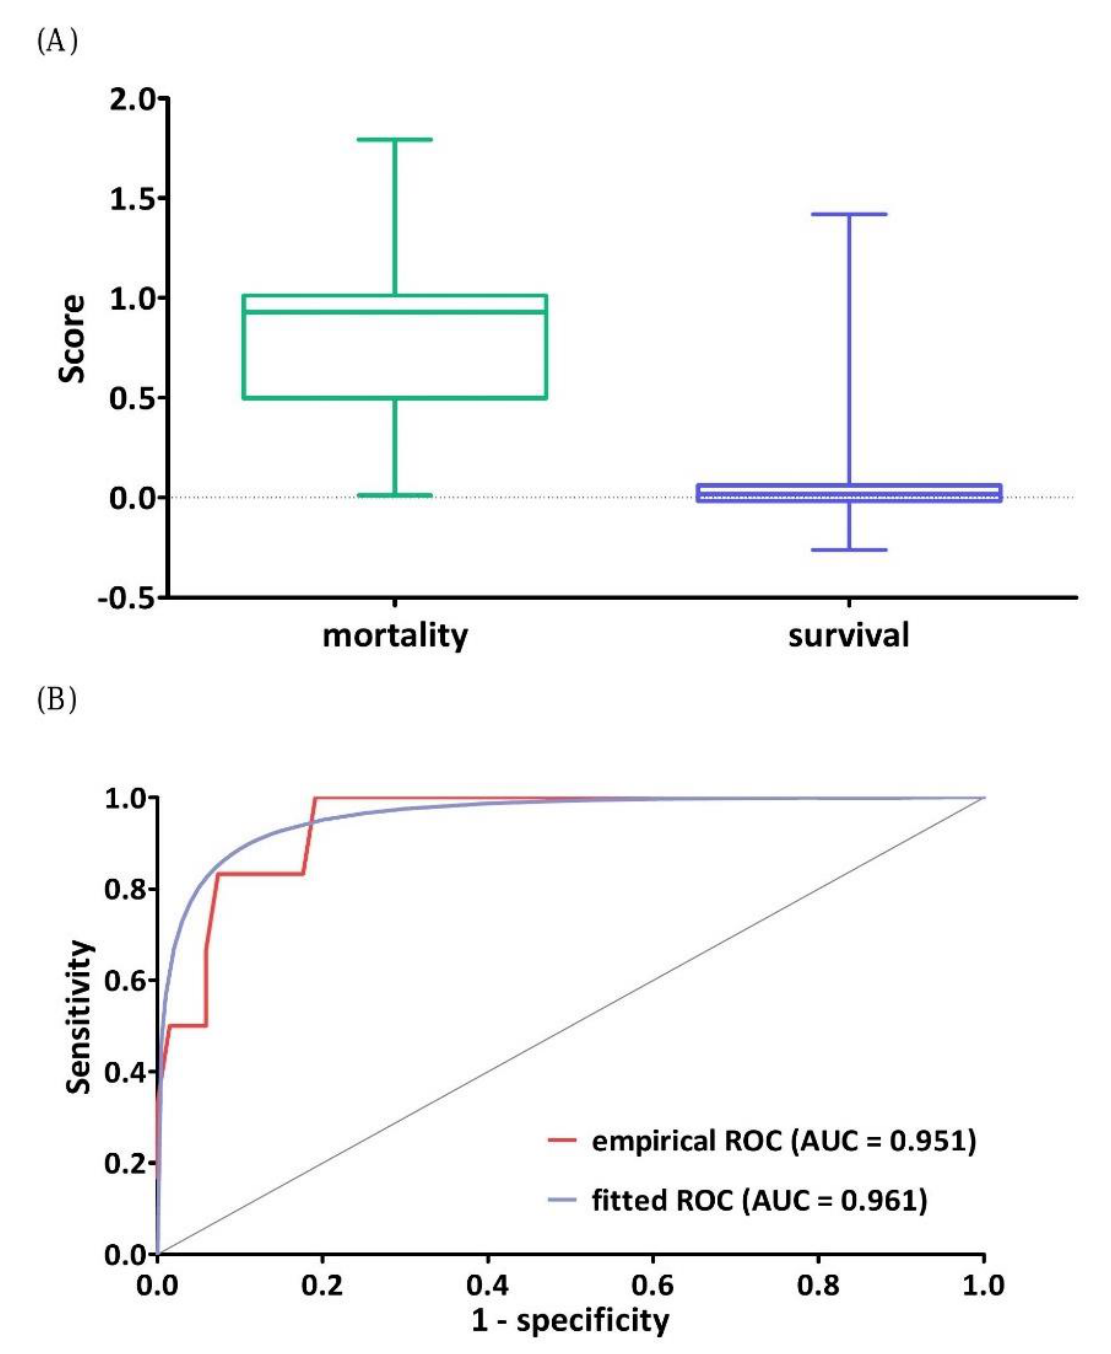
Figure 3. ( A ) Scores of the final survivors ( n = 302) were compared to those who died before discharge ( n = 28). ( B ) ROC curve analyses of the ability of the score to discriminate between the death group and the control group. ROC: receiver operating characteristic